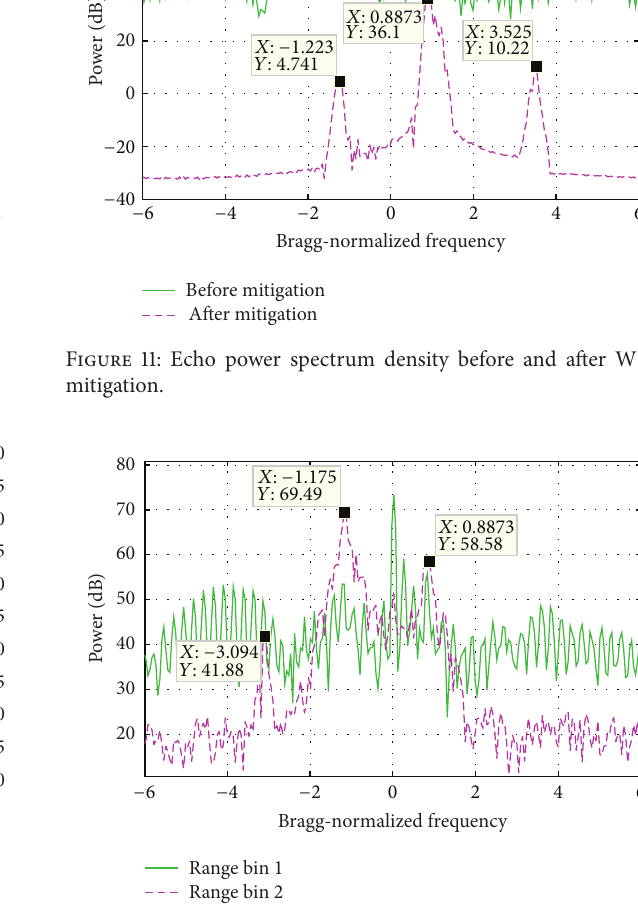
Figure 12: Echo power spectrum density of two range